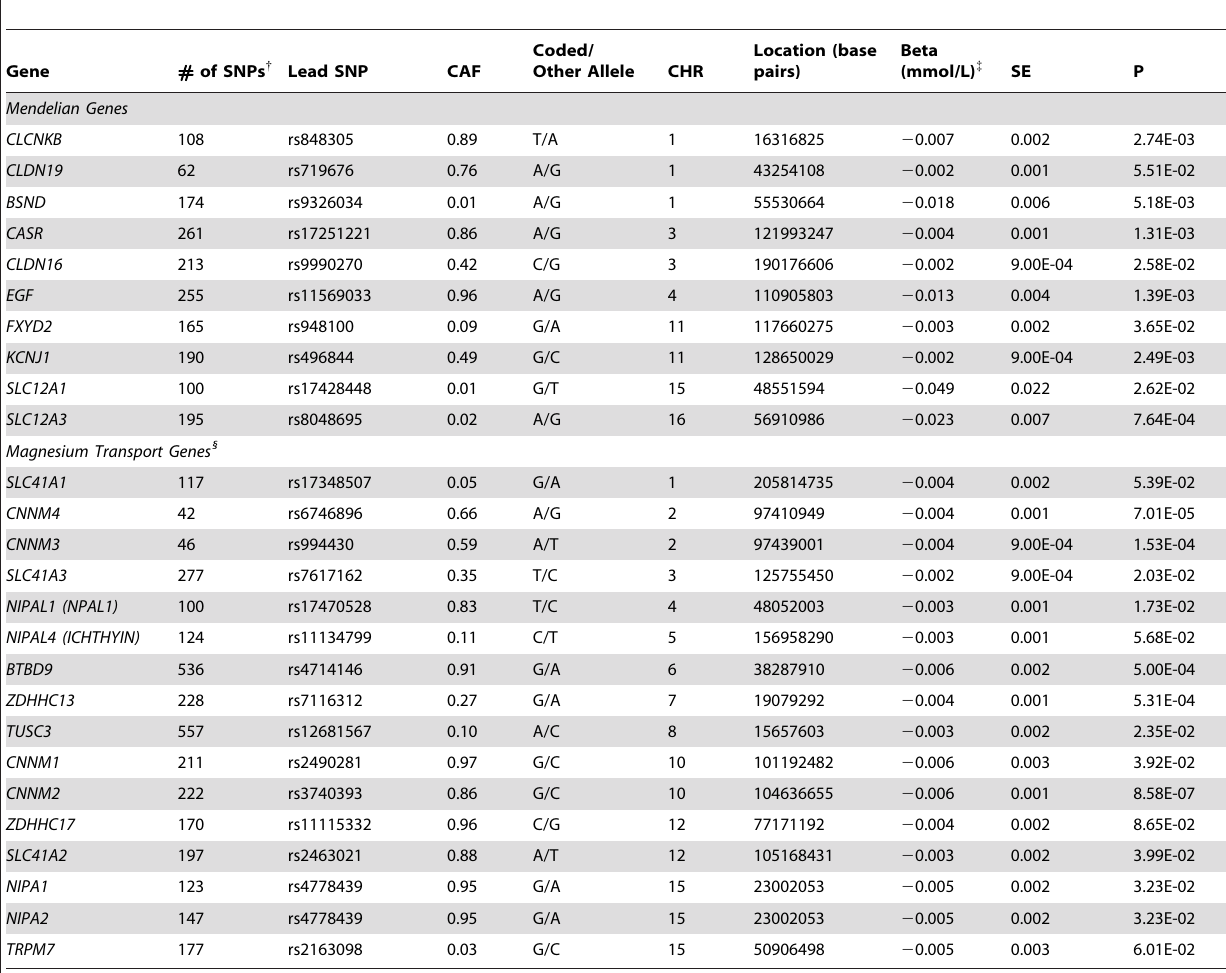
Table 4. SNPs in or near genes known to cause monogenic syndromes with abnormal magnesium metabolism or near known magnesium transport genes in association with serum magnesium in 15,366 participants from the CHARGE Consortium.